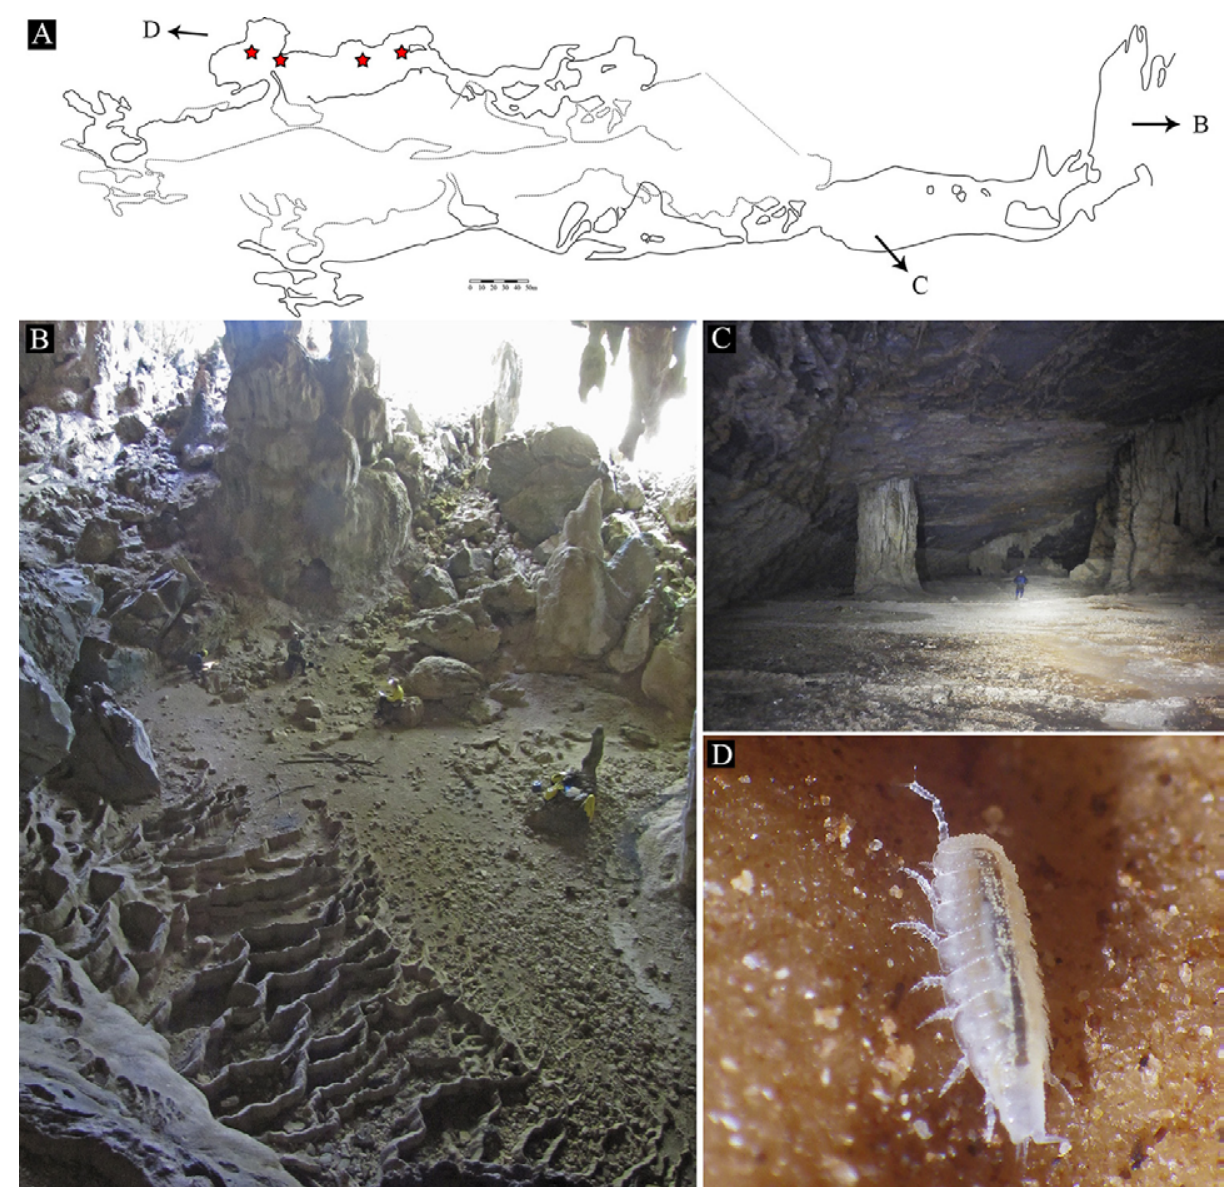
Figure 7. Pectenoniscus juveniliensis n. sp. A , cave map with collection sites; B , entrance of Gruta do Tabuleirinho, inside view; C , cave main hall; D , specimen of Pectenoniscus juveniliensis n. sp., approximately 3